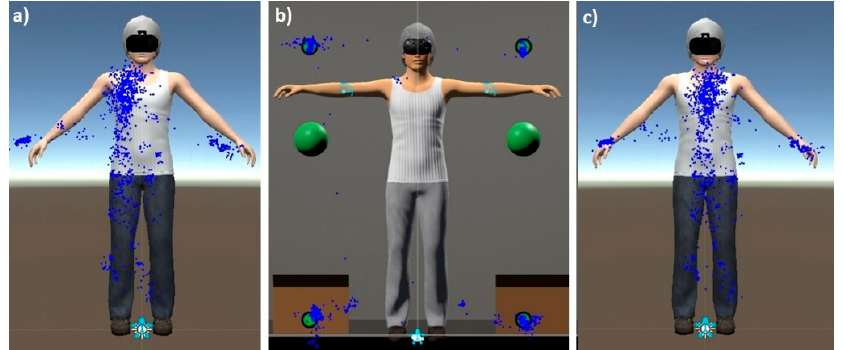
Figure 2. Drift correction procedure. From left to right: ( a ) example of RAW ET data; ( b ) adjustment based on four fixed “drift markers”; ( c ) drift-corrected ET data. Blue dots indicate the fixation pattern of the participant.